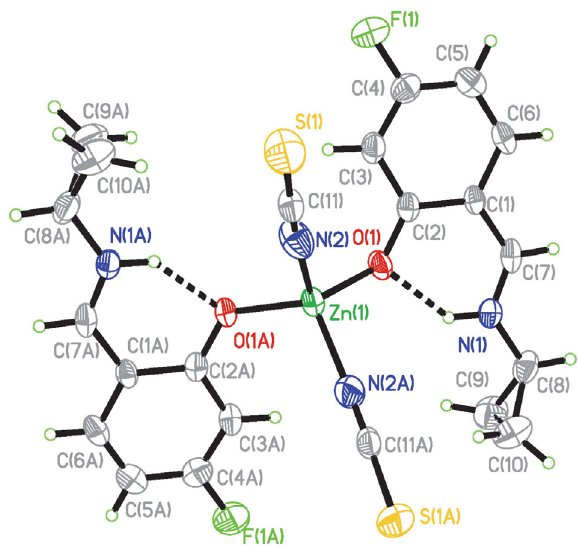
Figure 3. Molecular structure of complex 2 . Atoms labeled with the suffix A are at the symmetry position – x , y , 1/2 – z .